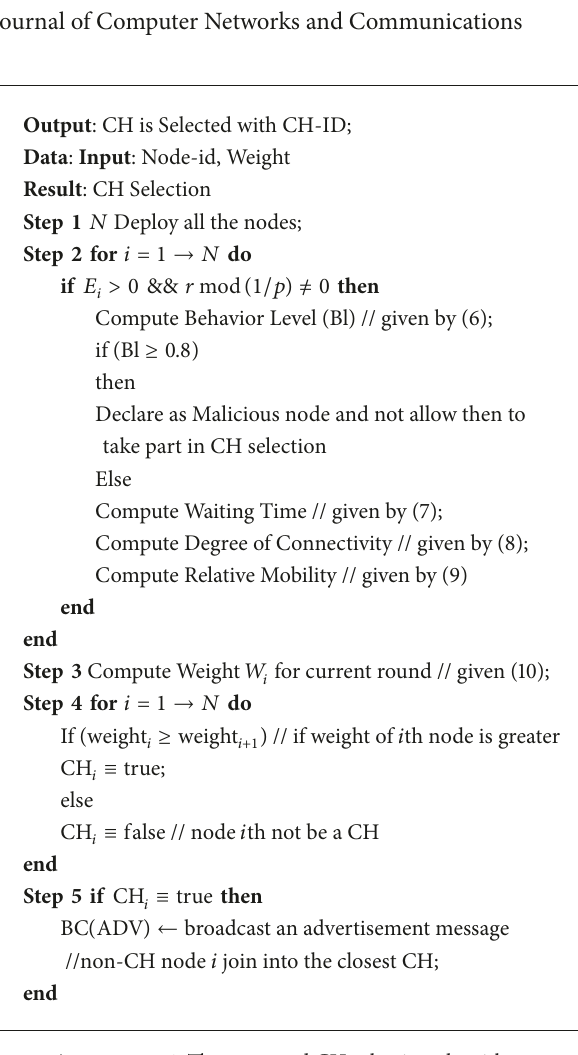
Algorithm 1: The proposed CH selection algorithm.